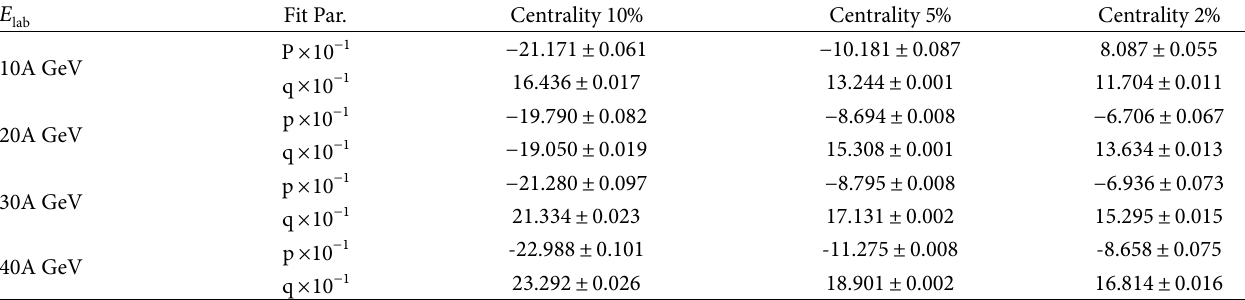
Table 6: Values of parameters, p and q, occurring in equation (2) at different energies.